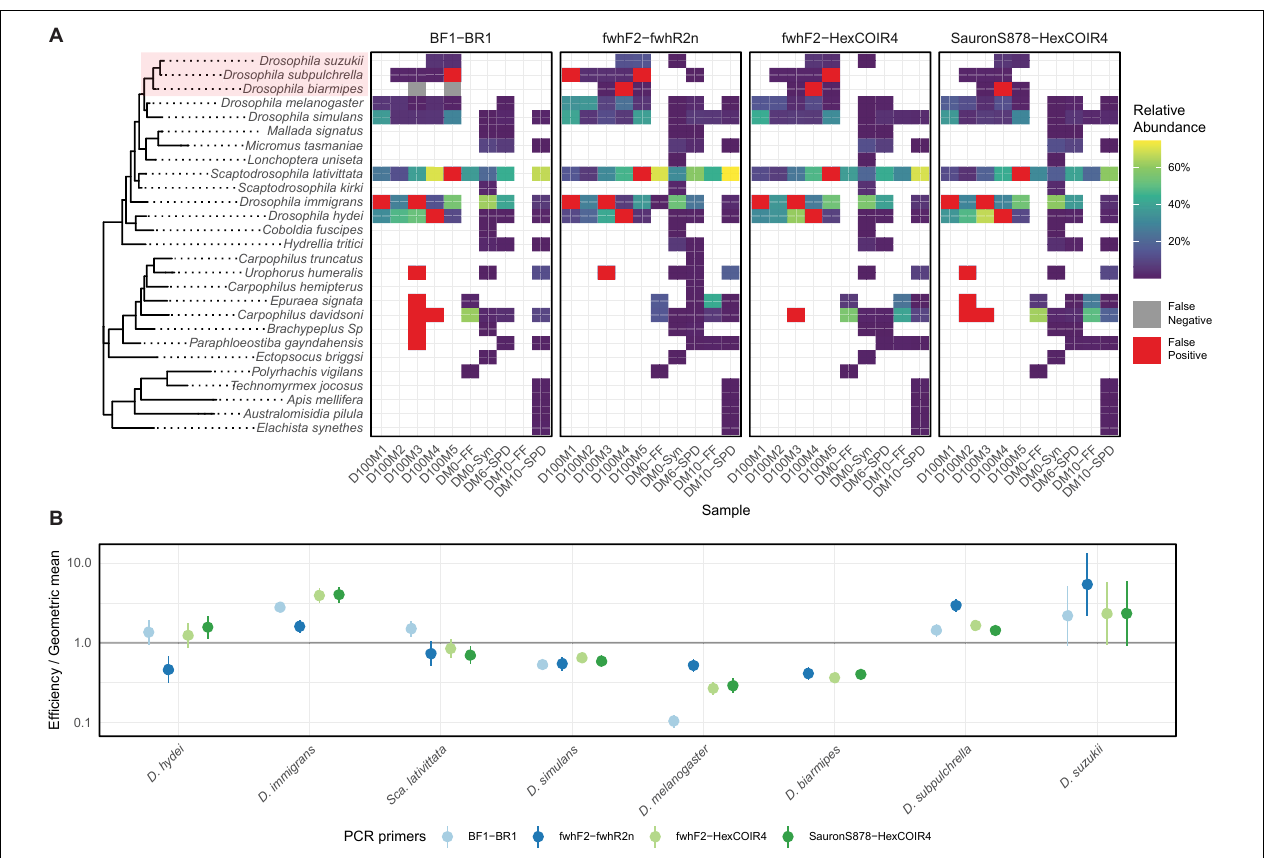
FIGURE 1 | (A) Per-sample relative read abundance (RRA) of detected species across the four evaluated primer sets, with false positive and false negative results within the mock community samples highlighted. (B) Relative primer amplification efficiency of each mock community species compared to the geometric mean efficiency, with standard errors obtained from 1,000 bootstrap resamples. Spiked-in species exotic to Australia highlighted in